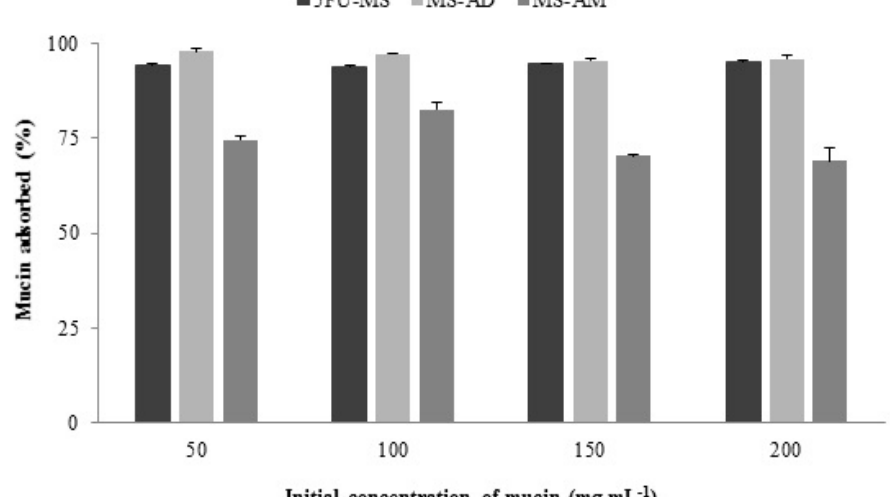
Figure 7. Concentration of mucin adsorbed (%) by 5FU-MS formulation, and MS-AM and MS-AD powders. Values obtained from the mean ± SD; n = 2).